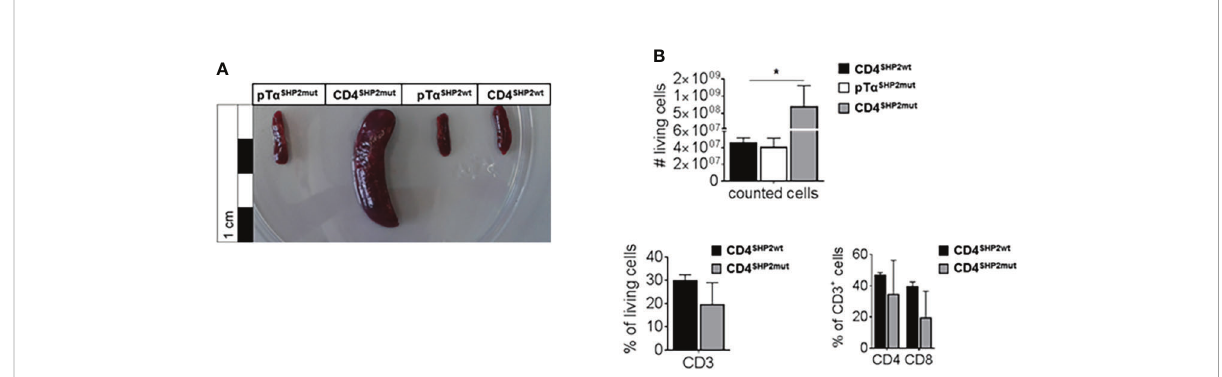
FIGURE 1 SHP2 mutation induces splenomegaly and increased cell numbers in CD4-Cre but not in pT a -Cre mice. CD4 SHP2mut , pT a SHP2mut and Cre- control mice were kept for 11 to 14 months; spleens were removed, photographed and further analyzed by fl ow cytometry. (A) Splenomegaly was observed in CD4 SHP2mut mice. (B) Splenocytes of aged naïve mice were isolated, gated on single living cells and used for further FACS analysis. Bar graph shows total cell numbers of pT a SHP2mut mice, CD4 SHP2mut or Cre-control mice (upper panel) and frequencies of CD3 + T cells as well as frequencies of CD4 + and CD8 + T cells within the CD3 + T cell population for CD4 SHP2mut compared to control mice (lower panels). Data are representative for 2 independent experiments with n = 2 SHP2 mutant or 3 control mice. (*p<0.05, Student ’ s t-test, mean +